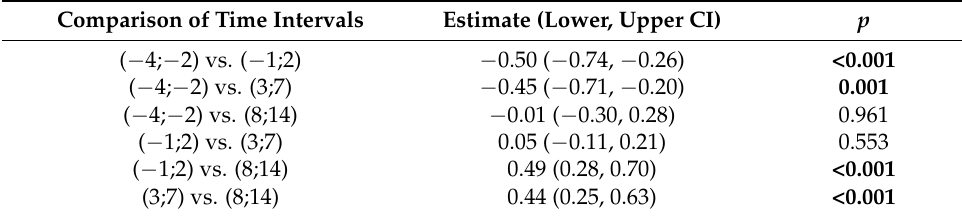
Table A4. Comparison of cytokine values other than interleukin 17A (IL-6, IL-8, IL-10, IL-17F, IL-22, IL-23, IFN- γ , TNF- α , PTX3, TGF- β ) between the different study groups at time interval ( − 1;2) ( p -values) (see Section